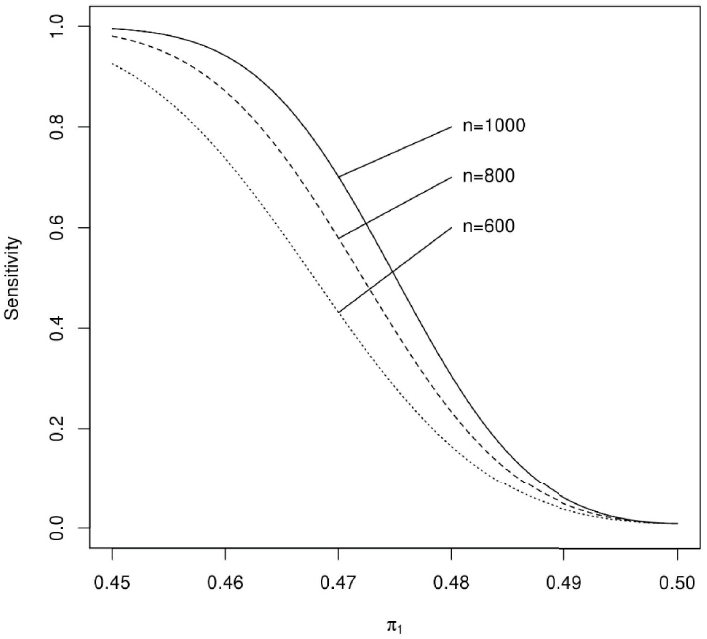
Fig 1. Assay sensitivity. The sensitivity of the assay as it depends on the number of cells per filed (n) and the probability that a cell is infected at the lowest dilution ( π 1 ) given that the probability a cell is infected in the virus only wells is 50% and c = 1.